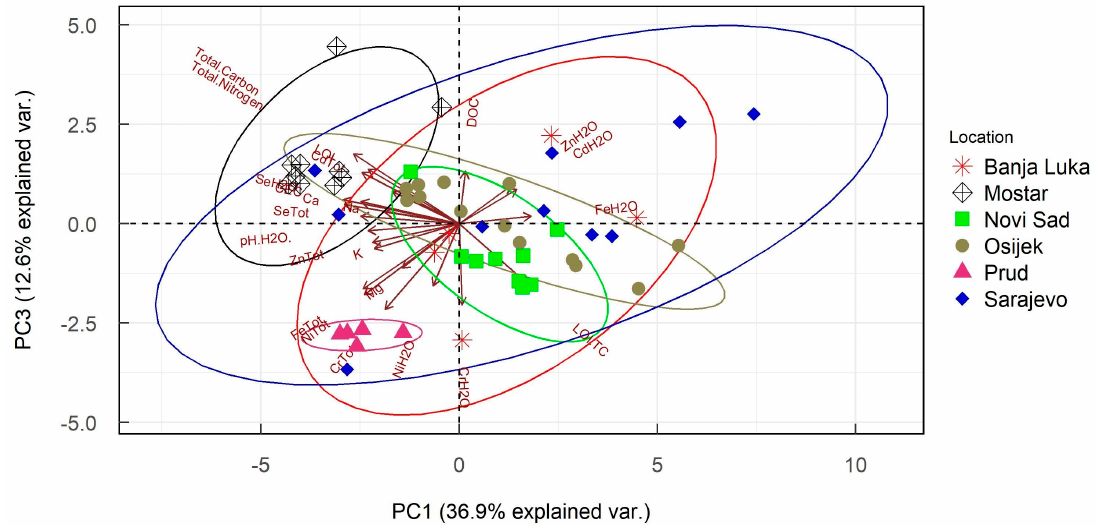
Figure 4. Biplot of principal components 1 and 3 from PCA analysis of variation among six locations with di ff erent soil properties. Arrows represent the eigenvalues of each of the 24 selected soil parameters.